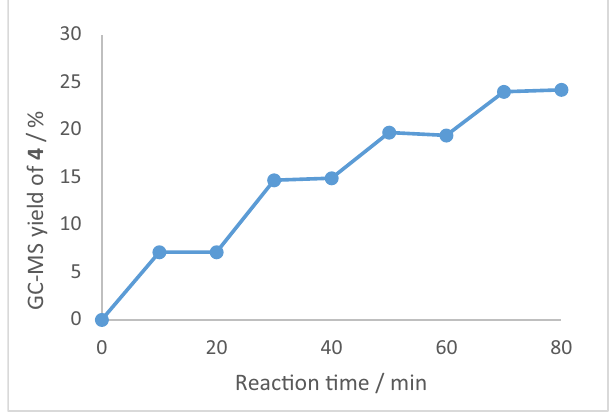
Fig. 8 | Light on/off experiments. The yield of ketone 4 determined by GC-MS using dodecane as an internal standard.